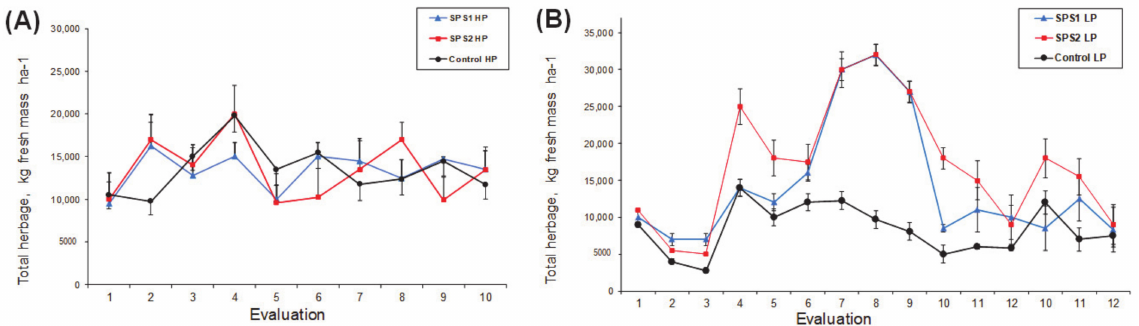
Figure 3. Total fresh mass of guinea grass Panicum maximum cv. Mombaça evaluated under silvopastoral systems and different seasons at the year p = 0.089. HP (35 days) ( A ); LP (45 days) ( B ).